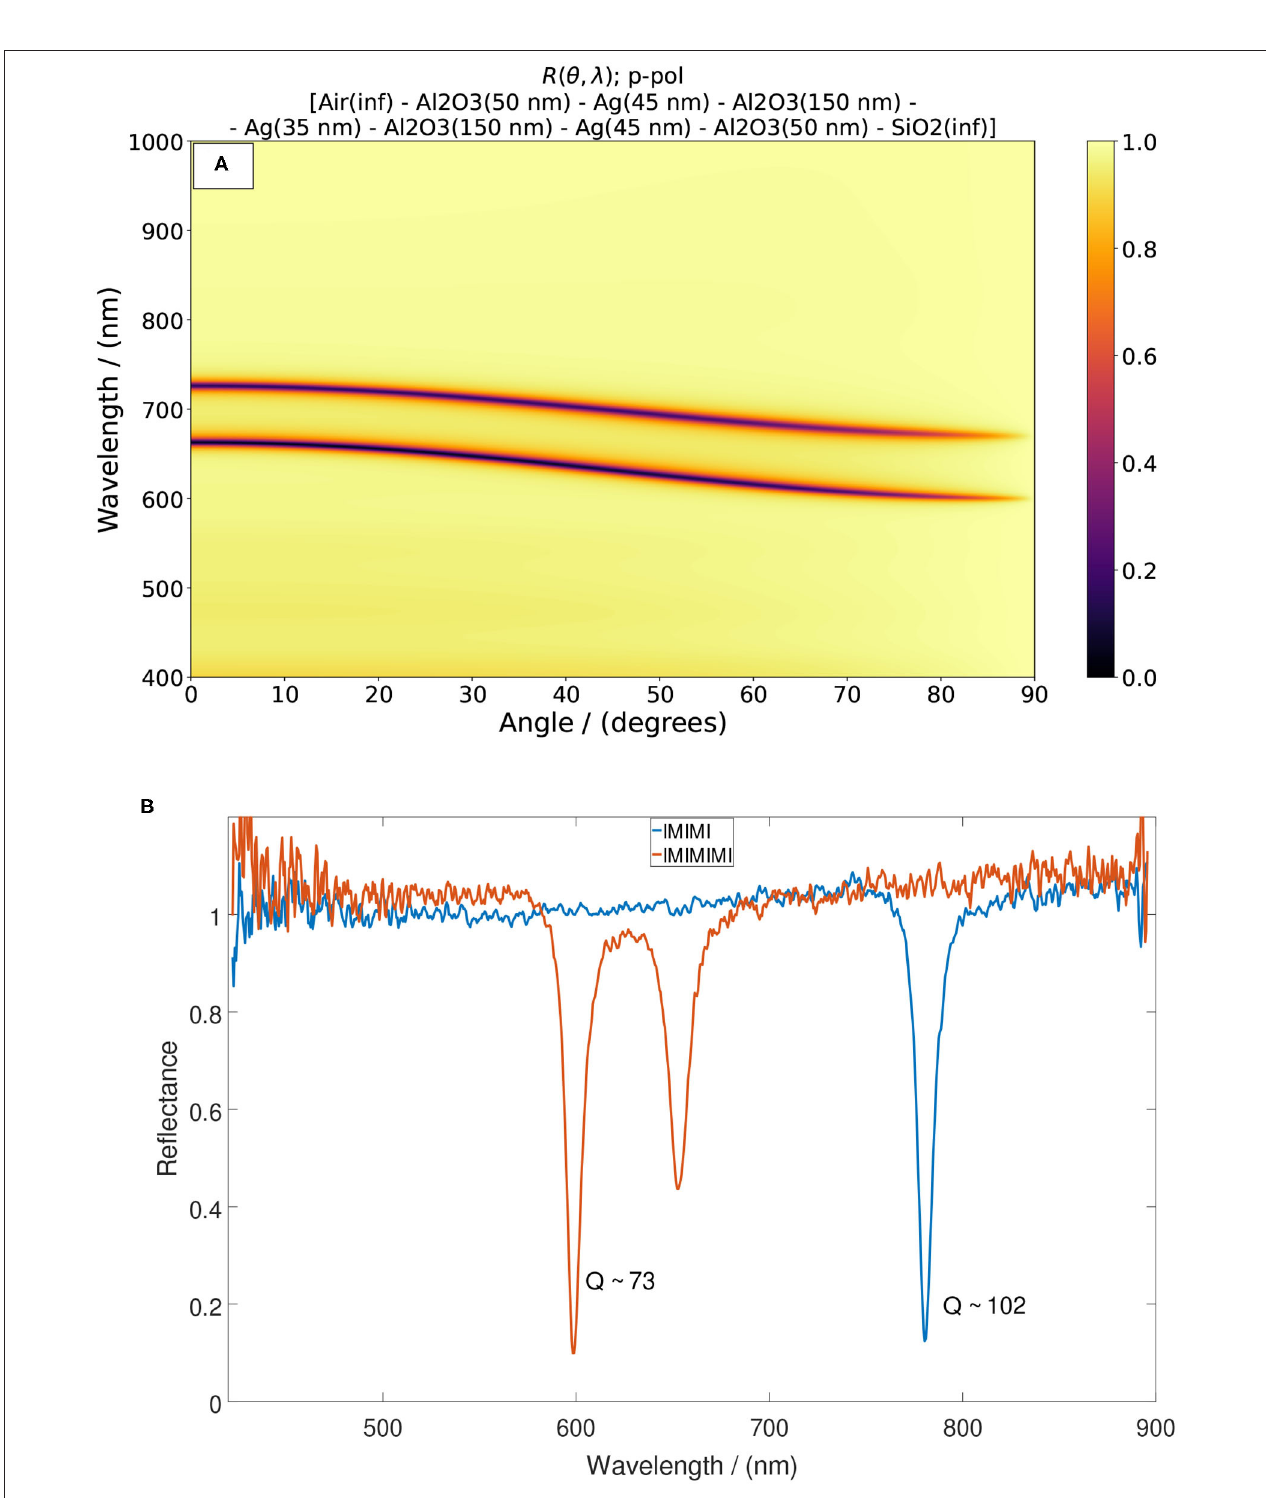
FIGURE 1 | (A) Reflectance of an IMIMIMI stack integrating two identical Fabry-Pérot cavities made of silver and aluminum oxide layers. The substrate is silicon dioxide and the first medium is air. (B) Experimental reflectance at normal illumination of two samples with single and double Fabry-Pérot cavities, indicating the respective Q